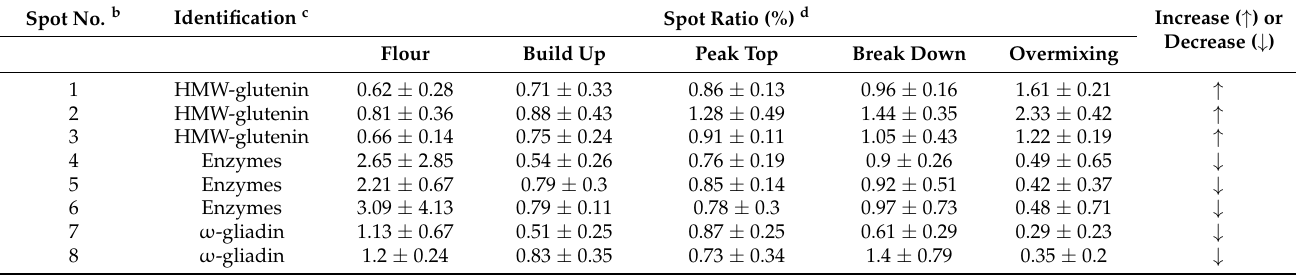
Table 4. The increased or decreased protein in monomeric protein extracted with 30% 1-propanol in LF a during mixing.